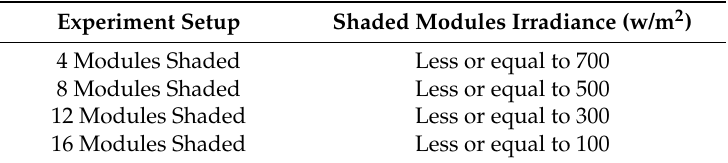
Table 10. Critical points for the maximum power to deliver at a lower voltage.